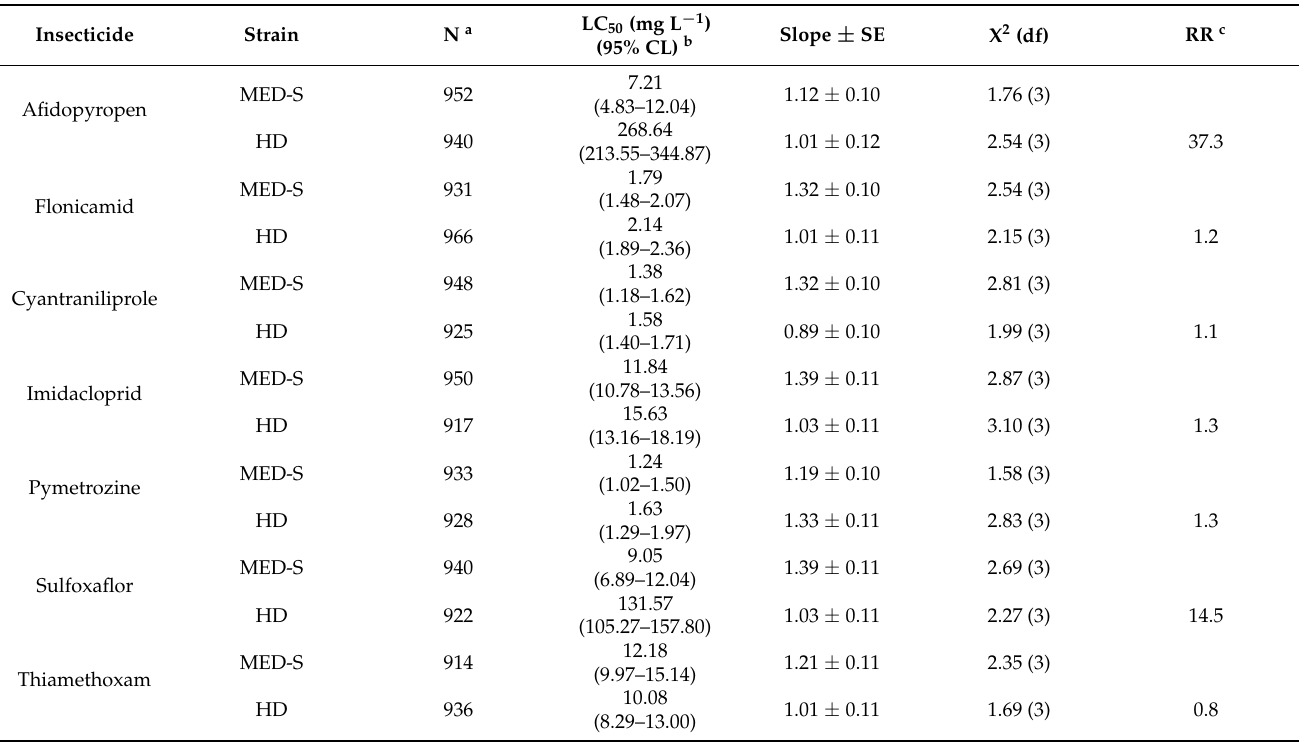
Table 3. Resistance spectrum of the susceptible MED-S and afidopyropen-resistant HD strains of B. tabaci